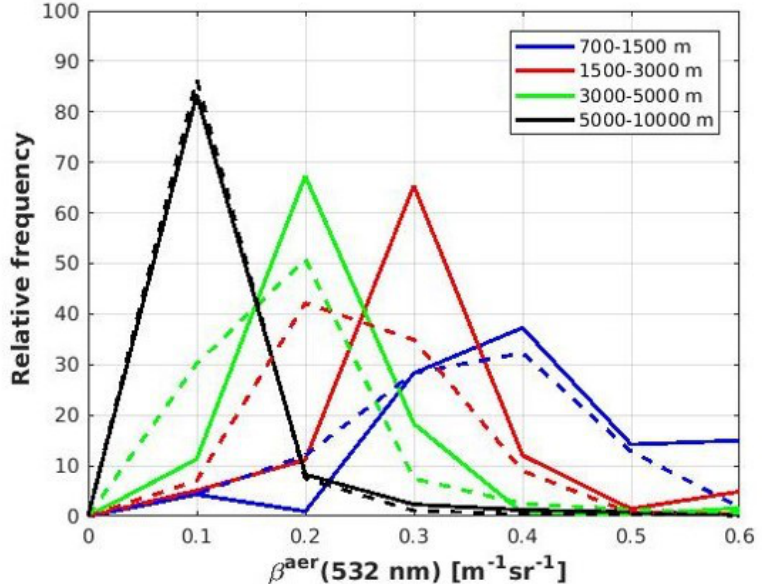
Figure 15. Aerosol backscatter data from 1 to 13 of March 2018 (Müller [45]) in comparison to the data from this study (all available data from March 2019). The filled lines (in italic ) represent the 2018 data, while the dashed lines represent the 2019 data (this study).